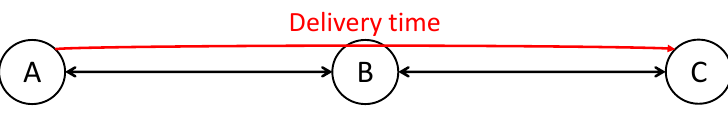
Figure 5. Two-hop delivery time evaluation (Table